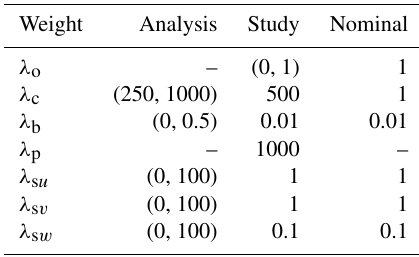
Table 3. Summary of 3DVAR constraint weights for stable solution derived from sensitivity analysis. Study values indicate the weight values used in this study. Nominal values reflect those used in pre- vious OSSE